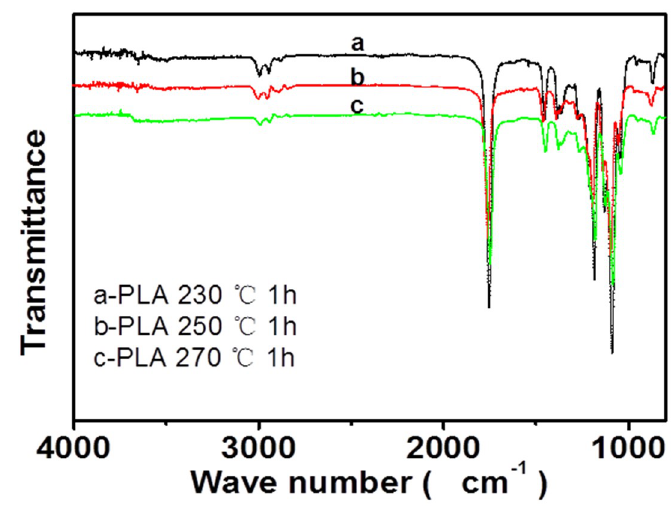
Figure 11. Infrared spectra of melt e-spun PLA fibers at different temperatures.